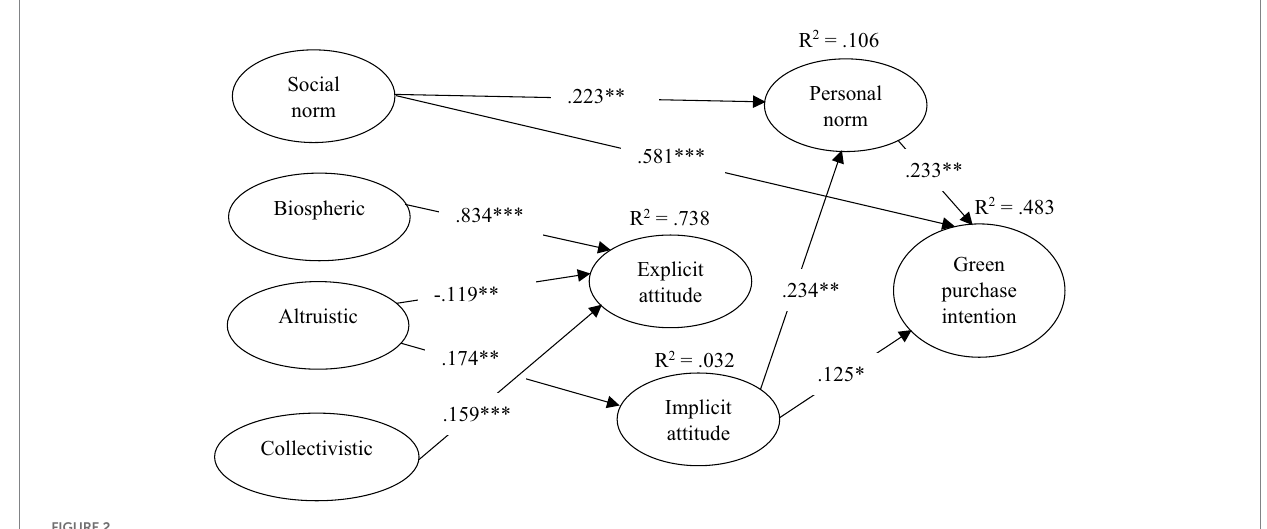
FIGURE 2 The structural model results. * p < 0.05, ** p < 0.01, *** p < 0.001, Critical ratio (C.R.) >